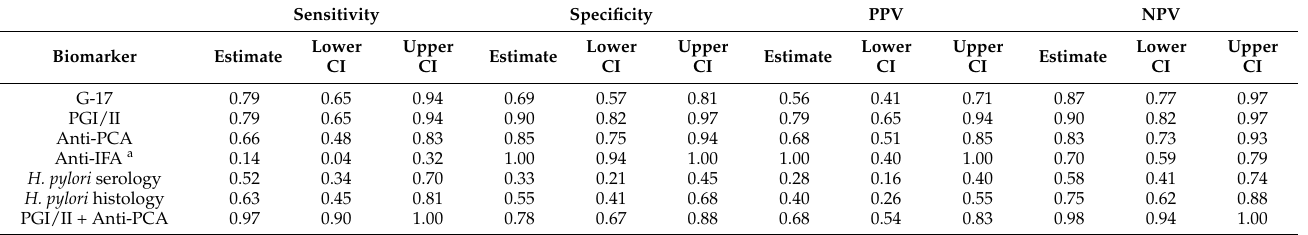
Table 3. Biomarker gastrin-17, anti-PCA, anti-IFA and PGI/II ratio sensitivity, specificity, positive predictive value, and negative predictive value for CRAG